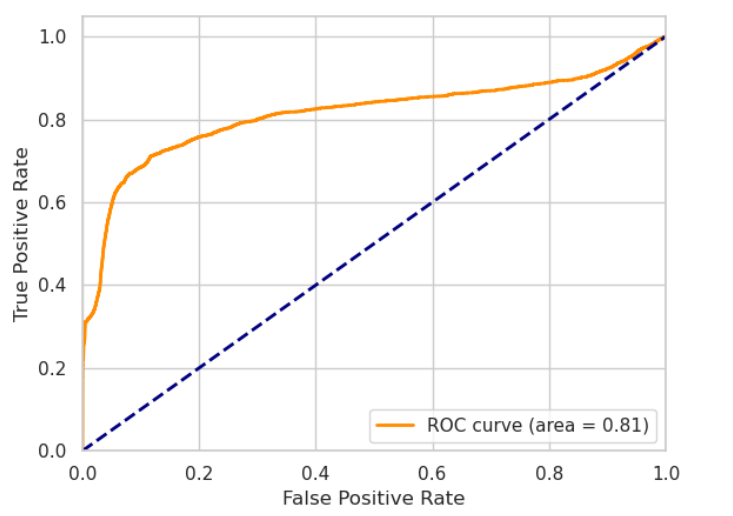
Figure 4. LW-LSTM-VAE-M (SWaT).